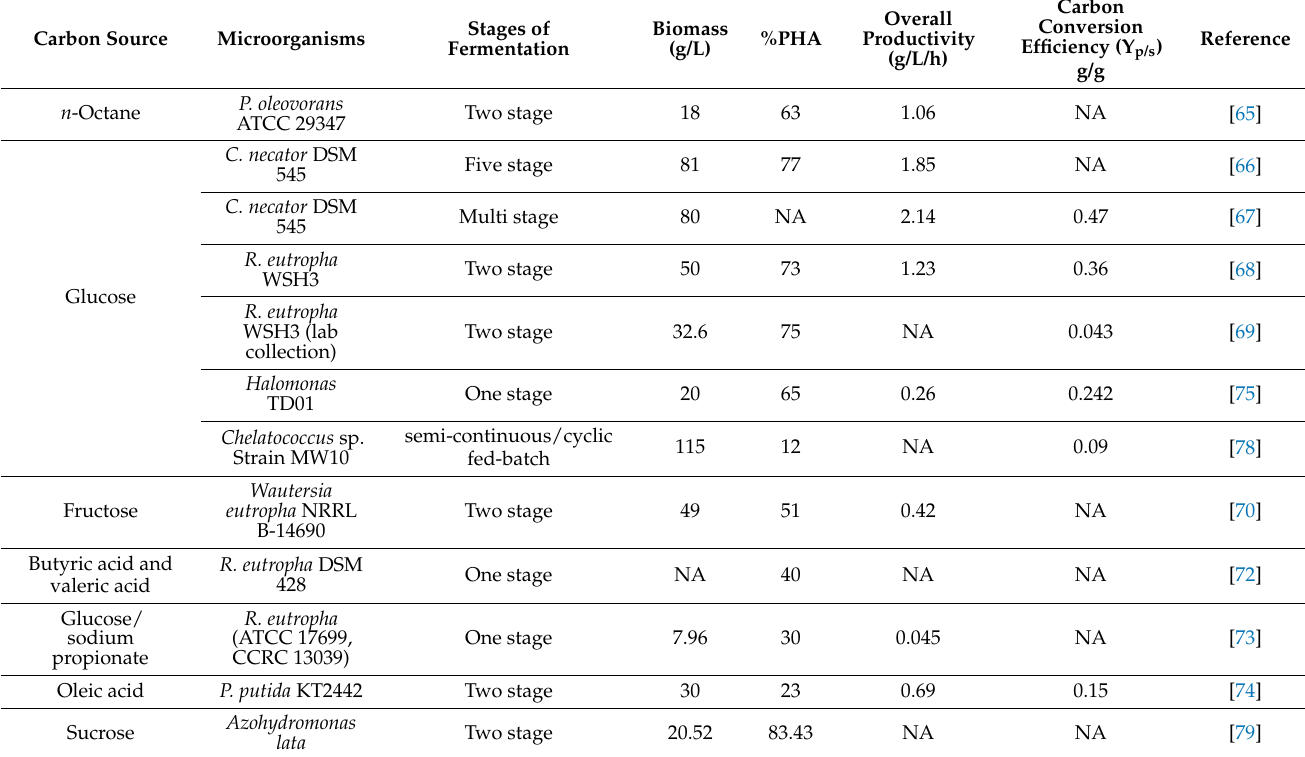
Table 2. PHA production by HCDC continuous mode operations without cell